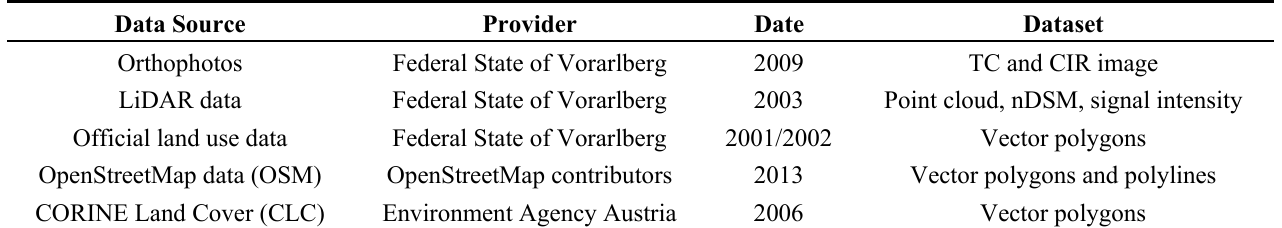
Table 1. Overview of data sources and datasets used as input for roughness map derivation and flood